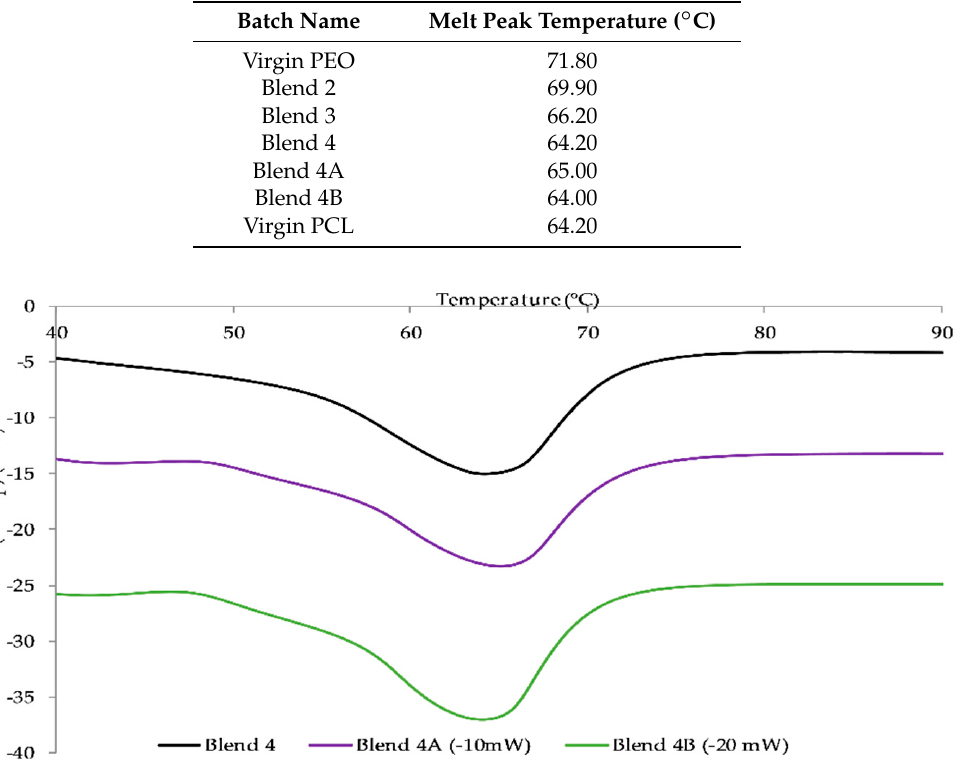
Figure 5. Overlaid differential scanning calorimetry (DSC) thermographs of Blend 4 and the two nanocomposite batches, Blend 4A and Blend 4B.